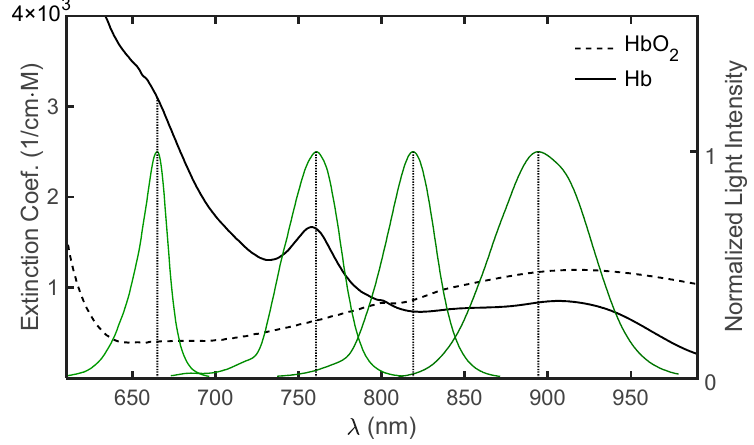
Figure 2. The normalized emitted light intensity spectra, obtained for light emitting diodes (LEDs) with peak wavelengths ( λ ) of 665 nm, 761 nm, 818 nm and 894 nm, and the extinction coefficient curves of Hb and HbO 2 , according to Zijlstra’s results.